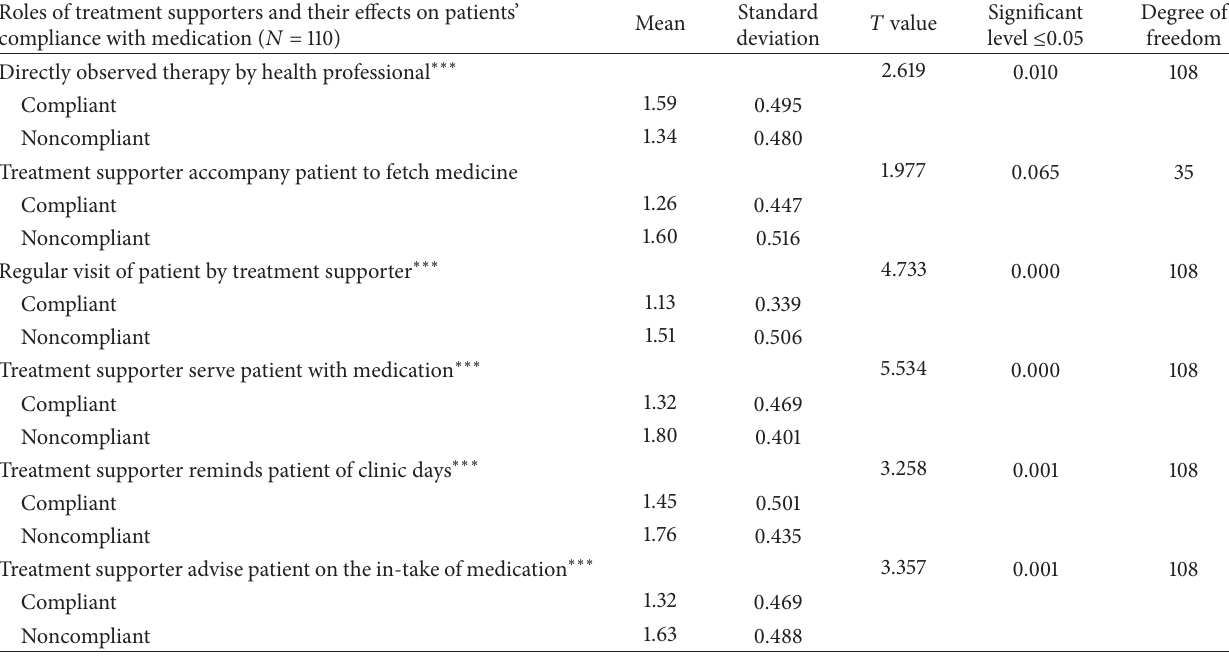
Table 2: Roles of treatment supporters by patients’ compliance with